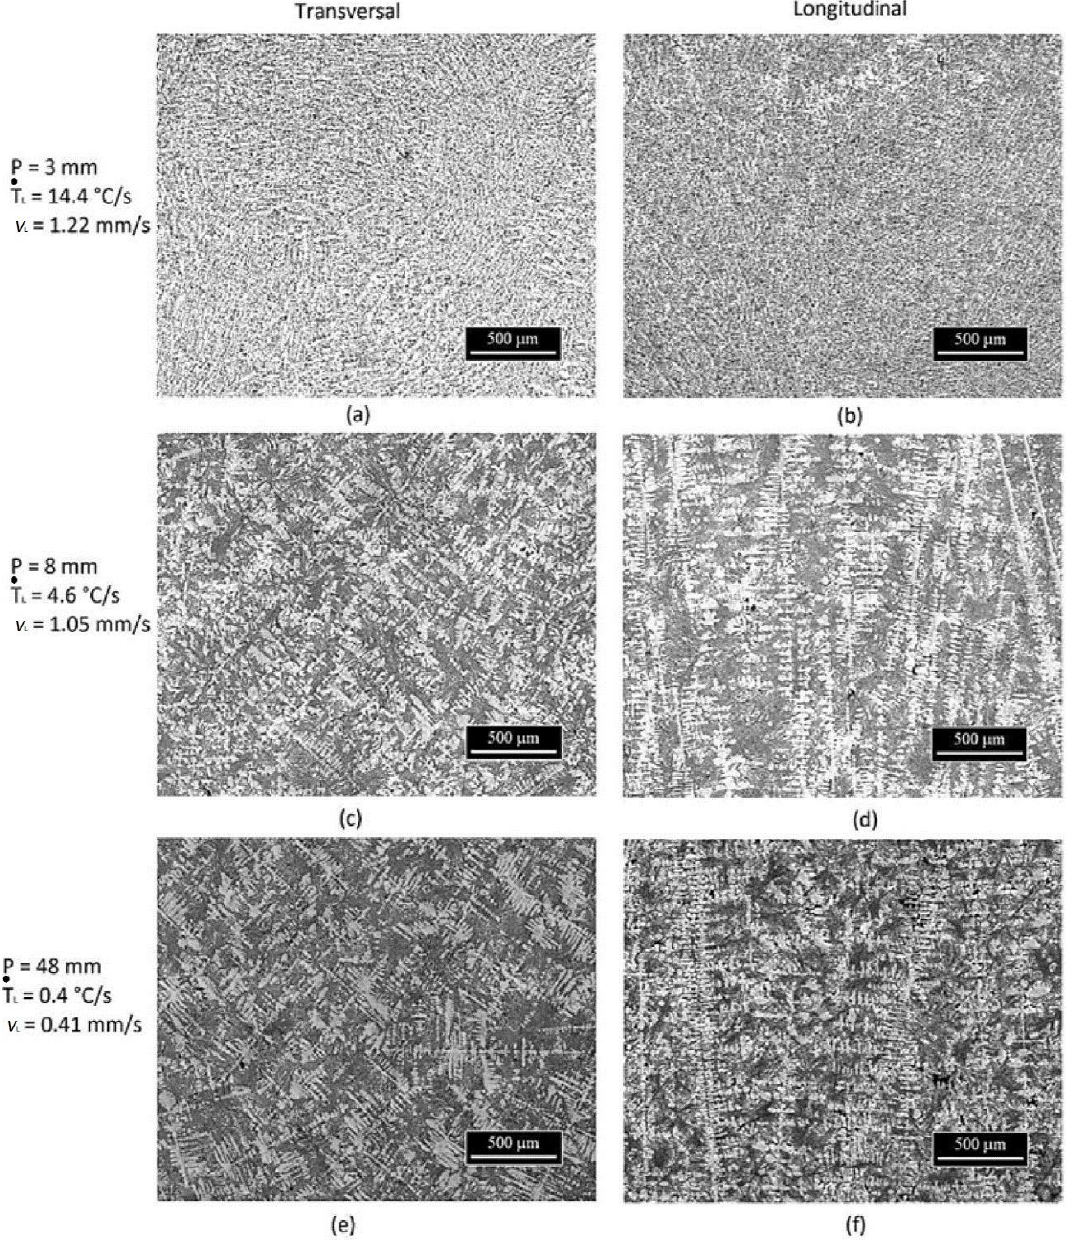
Figure 6. Optical microstructures representing different positions ( P ) along the casting length; that is, different cooling rates during solidification of the Al-11wt %Si-3.0wt %Cu alloy: ( a , b ) P = 3 mm, ( c , d ) P = 8 mm and ( e , f ) P = 48 mm.